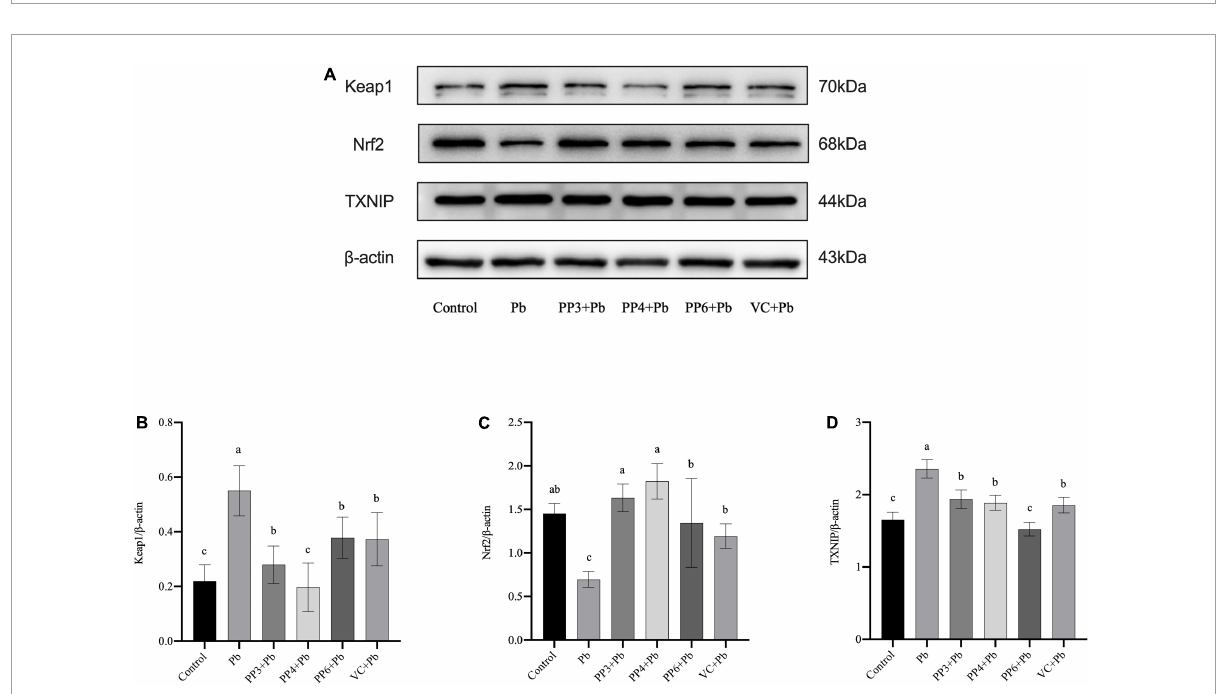
FIGURE5 Western blotting analysis of the effect of PP3, PP4, PP6, and VC on Keap1, Nrf2, and TXNIP expression in lead-exposed PC12 cells. PC12 cells were pre-incubated with PP3, PP4, PP6, and VC for 4 h, then treated with lead for 24 h. (A) The density of Keap1, Nrf2, and TXNIP was determined. (B) Represents data on the change in Keap1 protein expression relative to β -actin in different groups; (C) represents data on the change in Nrf2 protein expression relative to β -actin in different groups; (D) represents data on the change in TXNIP protein expression relative to β -actin in different groups. The valued of the bars indicates the means ± SD ( n = at least 3). Different superscript letters indicate differences ( P <